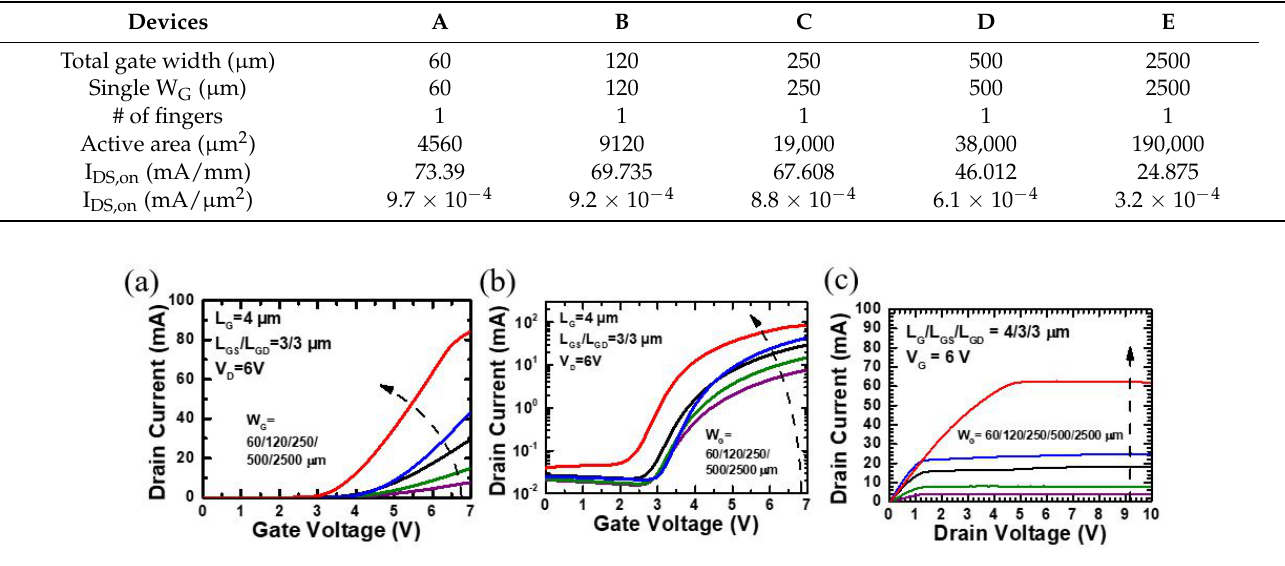
Figure 3. Device performance of single finger p-GaN HEMTs with different gate width (60/120/250/500/2500 μm) at V DS = 6 V: ( a ) I DS -V GS in linear scale, ( b ) I DS -V GS in log scale, ( c ) and output characteristics.